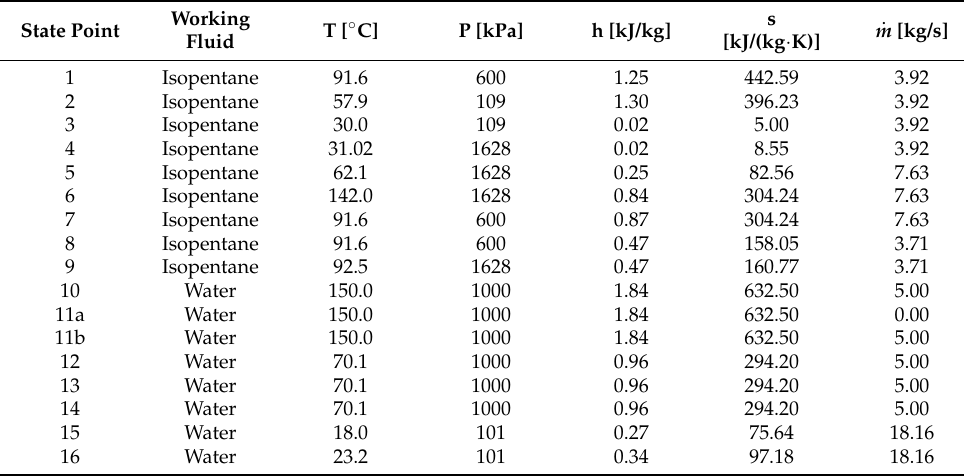
Table 4. Thermodynamic parameters of the optimized ROFC